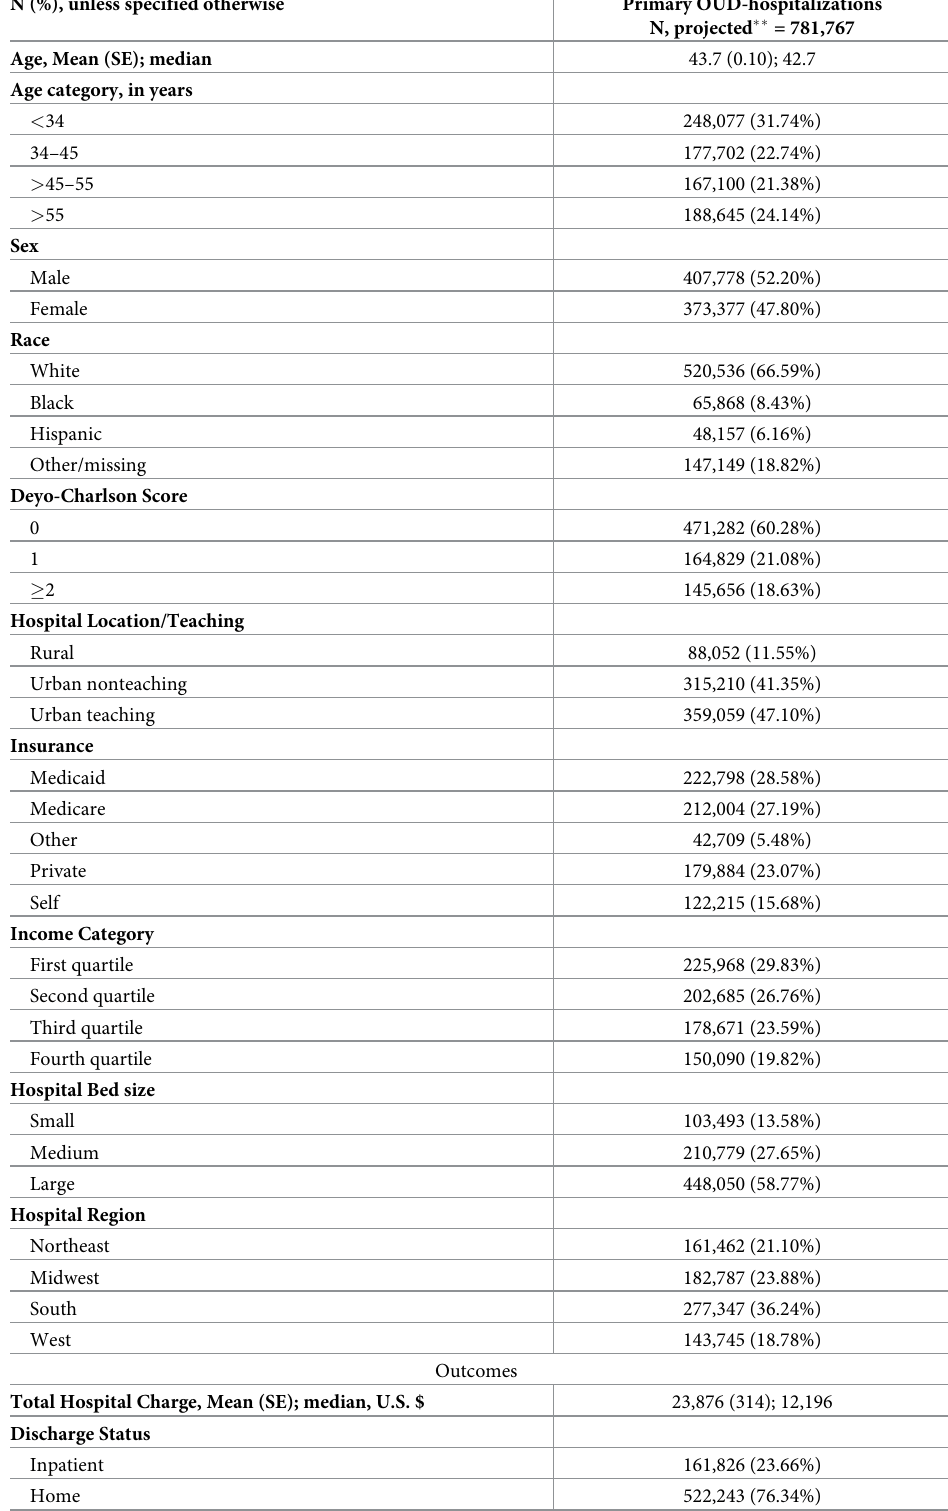
Table 1. Characteristics of people with opioid use disorder (OUD) � hospitalizations in the U.S. from